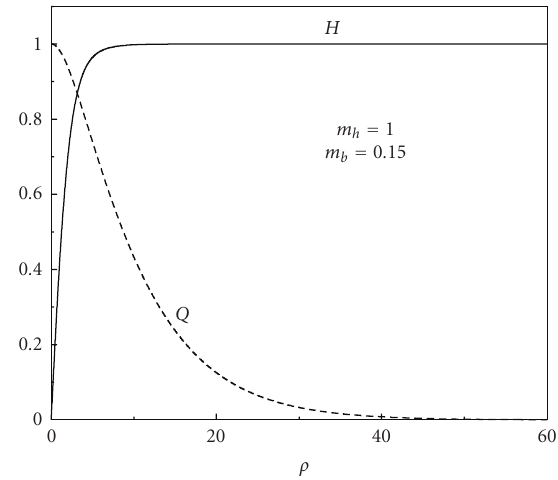
Figure 2: String forming field profiles in the Abelian Higgs model with unity winding number. The Higgs field H vanishes in the vortex core and reaches its vacuum expectation value within distances given by the Higgs Compton wavelength 1 /m h . The gauge field Q condenses inside the vortex over distances given by 1 /m b